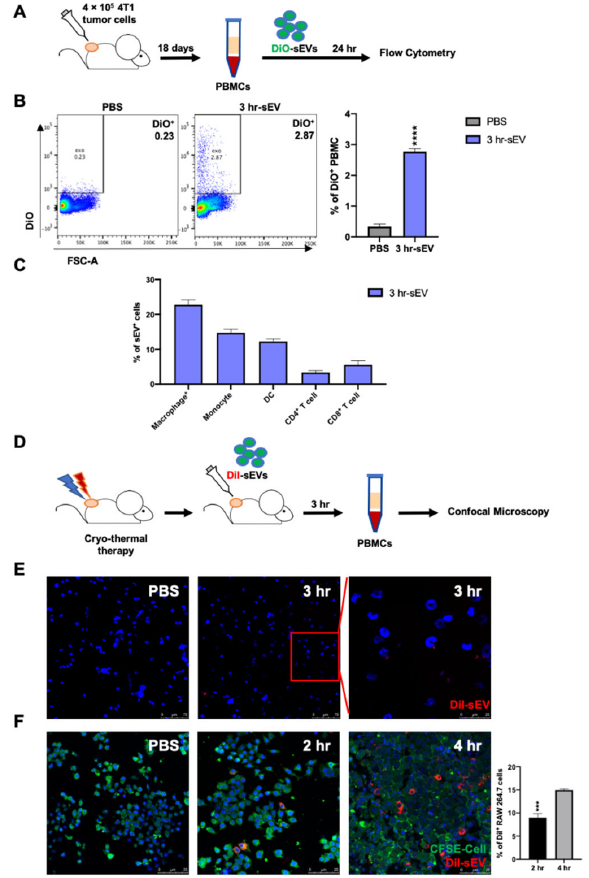
Figure 2. Phagocytosis of sEVs. ( A ) Schematic of experimental design. sEVs were labeled by DiO and PBS was dyed, diluted, and centrifuged as negative control. PBMCs isolated from tumor-bearing mice were cultured with DiO-labeled sEVs at 20 µ g/mL or PBS in vitro for 24 h. The proportion of phagocytosis of sEVs in PBMCs was detected by using flow cytometry. ( B ) The proportion of phagocytosis of sEVs by PBMCs. ( C ) The proportion of macrophages (F4/80 + CD11b + ), monocytes (Ly6G − Ly6C hi CD11b + ), DCs (CD11c hi ), CD4 + T cells (CD3 + CD4 + ), and CD8 + T cells (CD3 + CD8 + ) of 3 hr-sEV positive PBMCs. ( D ) Schematic of experimental design. DiI-labeled sEVs were injected into mice immediately after cryo-thermal therapy via the tail vein; 3 h later, PBMCs were isolated and observed by using confocal fluorescence microscope. ( E ) Qualitatively displayed that some cells with large kidney-shaped nuclei in PBMCs were co-located with sEVs. PBMCs isolated from cryo-thermal therapy-treated mice with or without sEVs supply (50 µ g) i.v. injection were fixed on adhesion slides and analyzed by using confocal microscopy. In the overlay, sEVs appear as red dots and were co-located with cells of large, kidney-shaped nuclei. ( F ) Uptake of sEVs by RAW 264.7 cells (20 µ g/mL). CFSE-labeled RAW264.7 cells were incubated with DiI-labeled sEVs for 2 or 4 h. Cells were fixed on adhesion slides and analyzed by using confocal microscopy. In the overlay, serum sEVs appear as red dots and the uptake was quantitated using ImageJ. Data were shown as mean ± SD, and the Student’s t -test was used for statistical analysis. n = 4, *** p < 0.001, **** p <